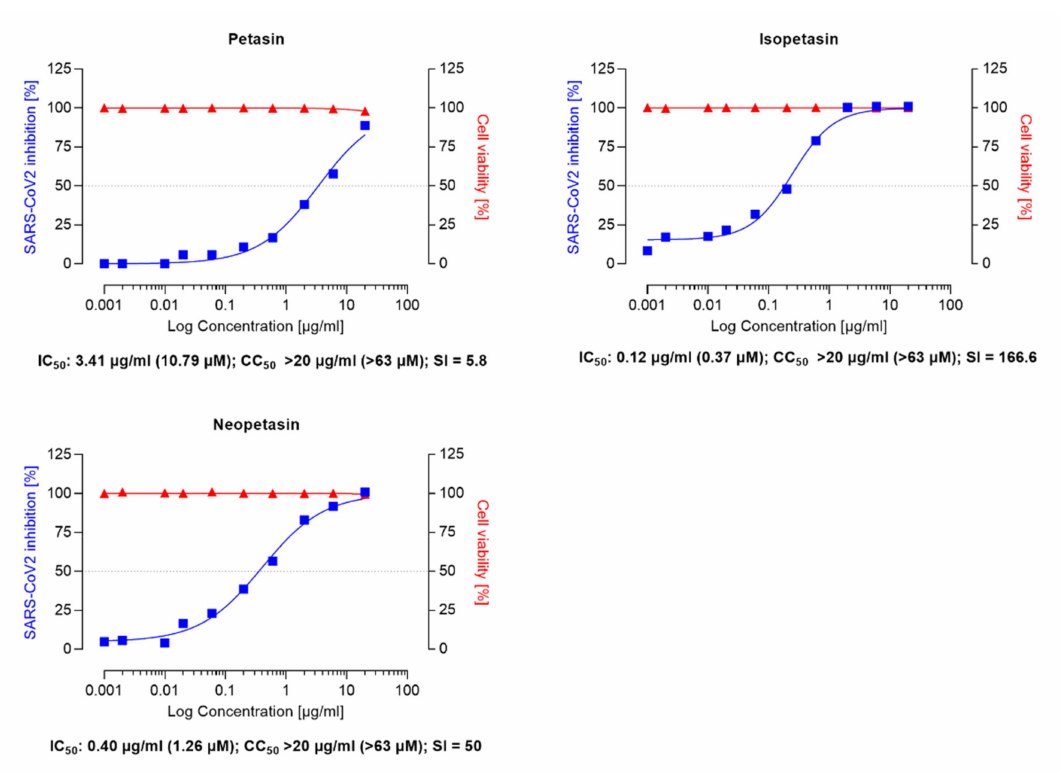
Figure 3. Anti-SARS-CoV-2 activity of the isopetasin and neopetasin in VeroE6 cells was assessed using the Wuhan strain of SARS-CoV-2. Cells were infected with 100 pfu of a clinical virus isolate in the presence of the indicated concentrations. Blue squares represent inhibition of SARS-CoV-2 infection (%), and red triangles represent cell viability (%). Data are expressed as the mean of two replicates (performed in duplicate) with their respected 95% confidence interval. Petasin confidence interval = 2.70–4.31, goodness of fit = 0.9874; Isopetasin 95% confidence interval = 0.15–0.41, goodness of fit = 0.9918; neopetasin 95% confidence interval = 0.27–0.55, goodness of fit =